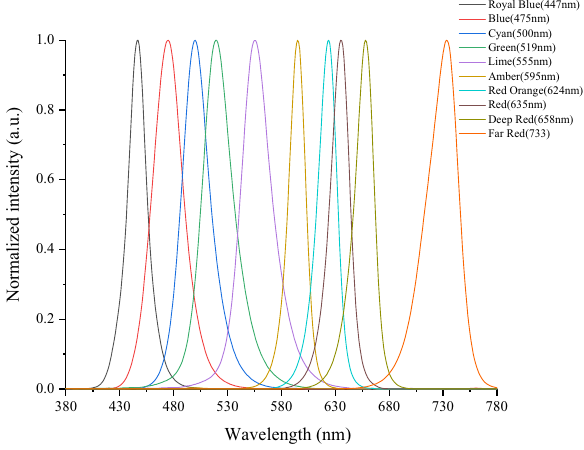
Figure 1. The relative SPDs of ten narrow-band light